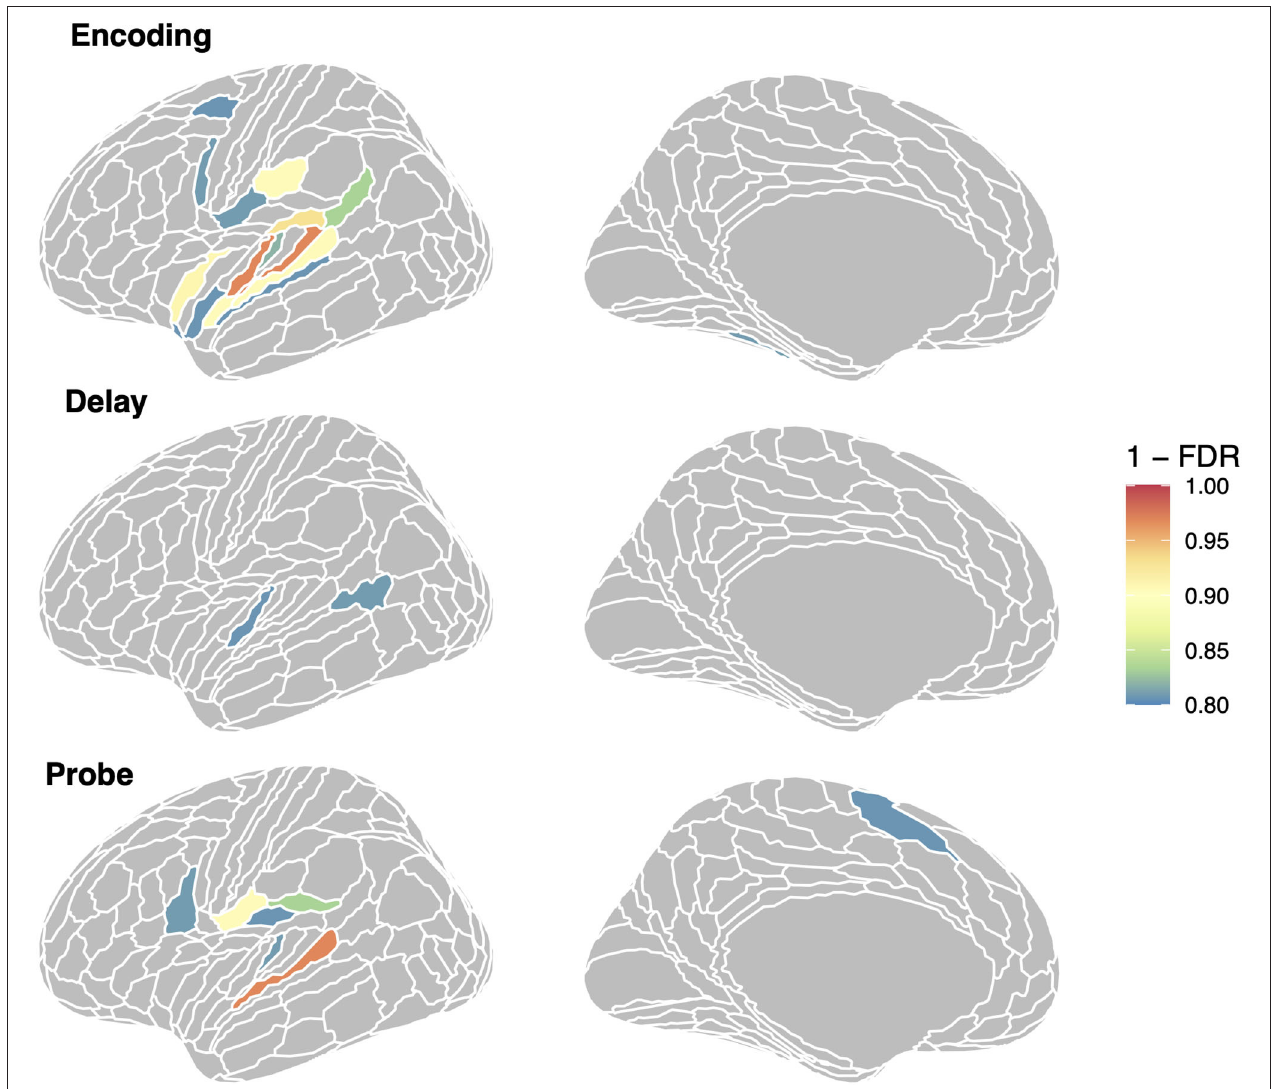
FIGURE 8 | Regions showing repeated sequence RSA effects in the auditory-motor network. We show all regions with (1–FDR > 0.8); region in orange/red are significant at the FDR < 0.05 level.